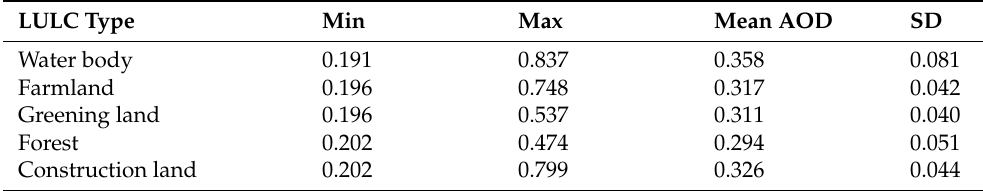
Table 2. Statistics of mean AOD (Aerosol Optical Depth) values in different LULC (Land use/Land cover) types in